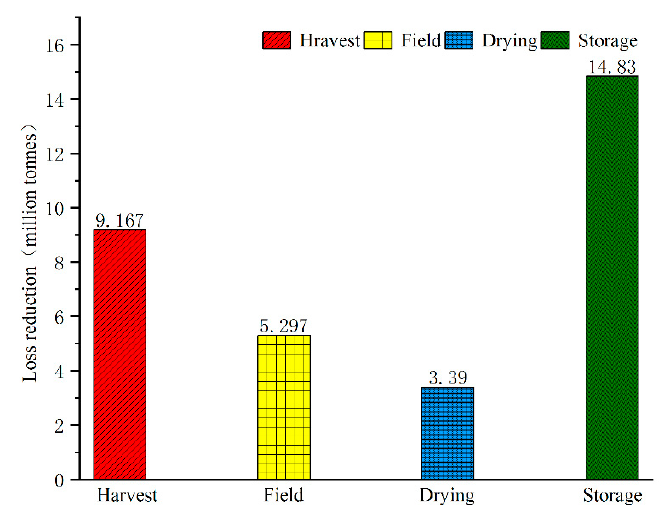
Figure 13. Rice loss reduction in different periods after implementing 5T management.